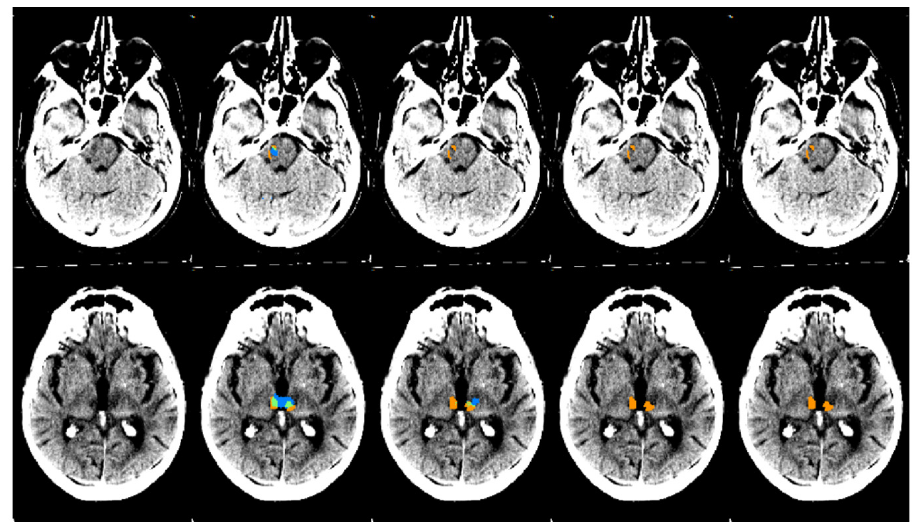
Figure 3. An example of automatic segmentation results obtained by the four CNNs on the PCS test set. From the left to the right column: the original scan, the automatic segmentation results from the TL-CNN, PCS-CNN, CD-CNN, and ACS-CNN are shown. The segmentation maps show true positives (green), false positives (blue), and false negatives (orange). The scans were plotted using a window center around 35, with a window width of 30.